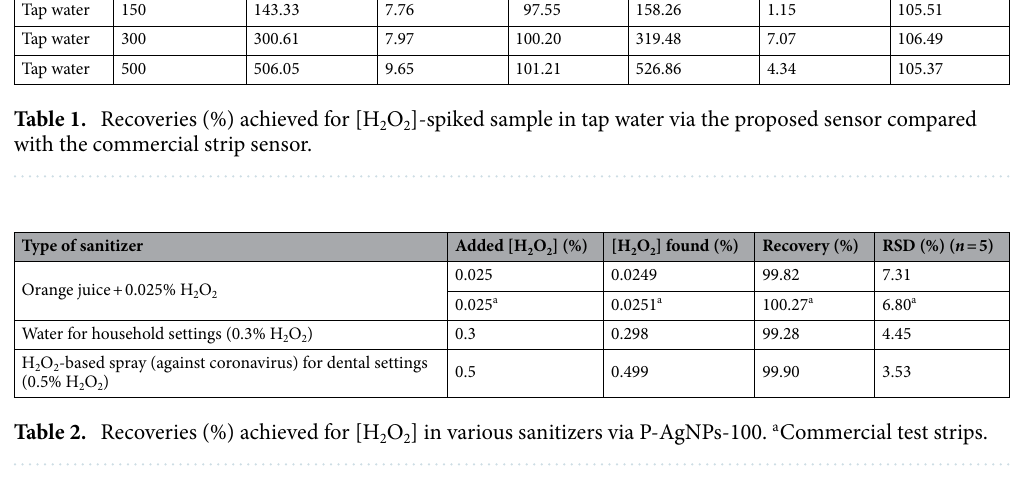
Table 2. Recoveries (%) achieved for [H 2 O 2 ] in various sanitizers via P-AgNPs-100. a Commercial test strips.